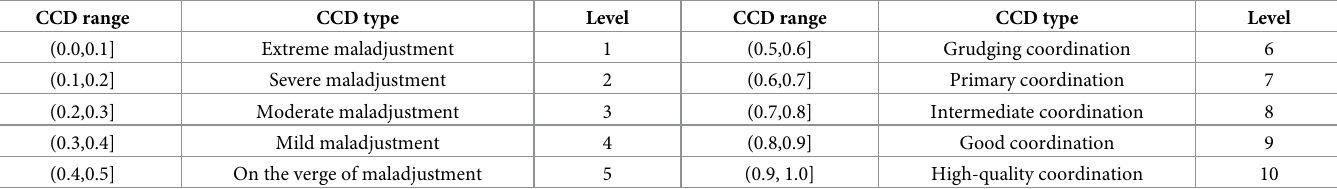
Table 4. Evaluation criteria for CCD.